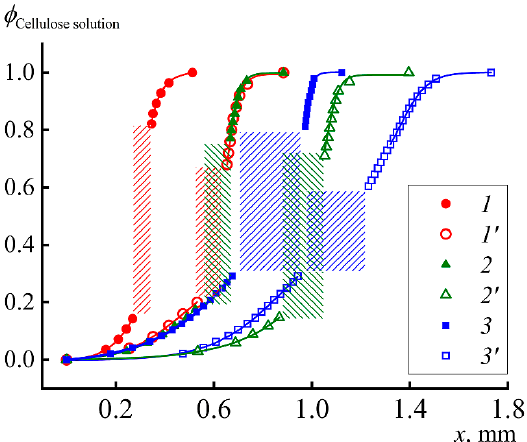
Figure 13. Position of the coagulation front in 1 min after moment of reagents contact (the shaded domains). Coagulants: IBA 25 ◦ C (1); IBA 90 ◦ C (1’); IPA 25 ◦ C (2); IPA 80 ◦ C (2’); H 2 O 25 ◦ C (3); and H 2 O 90 ◦ C